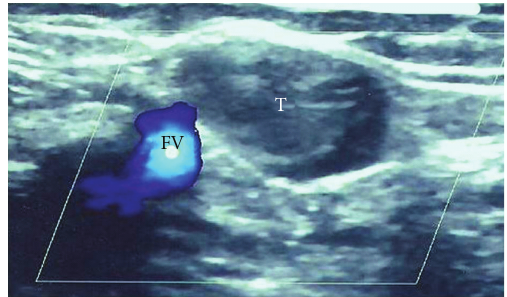
Figure 5: The US scan shows the great Saphenous vein aneurysm in communication with the femoral